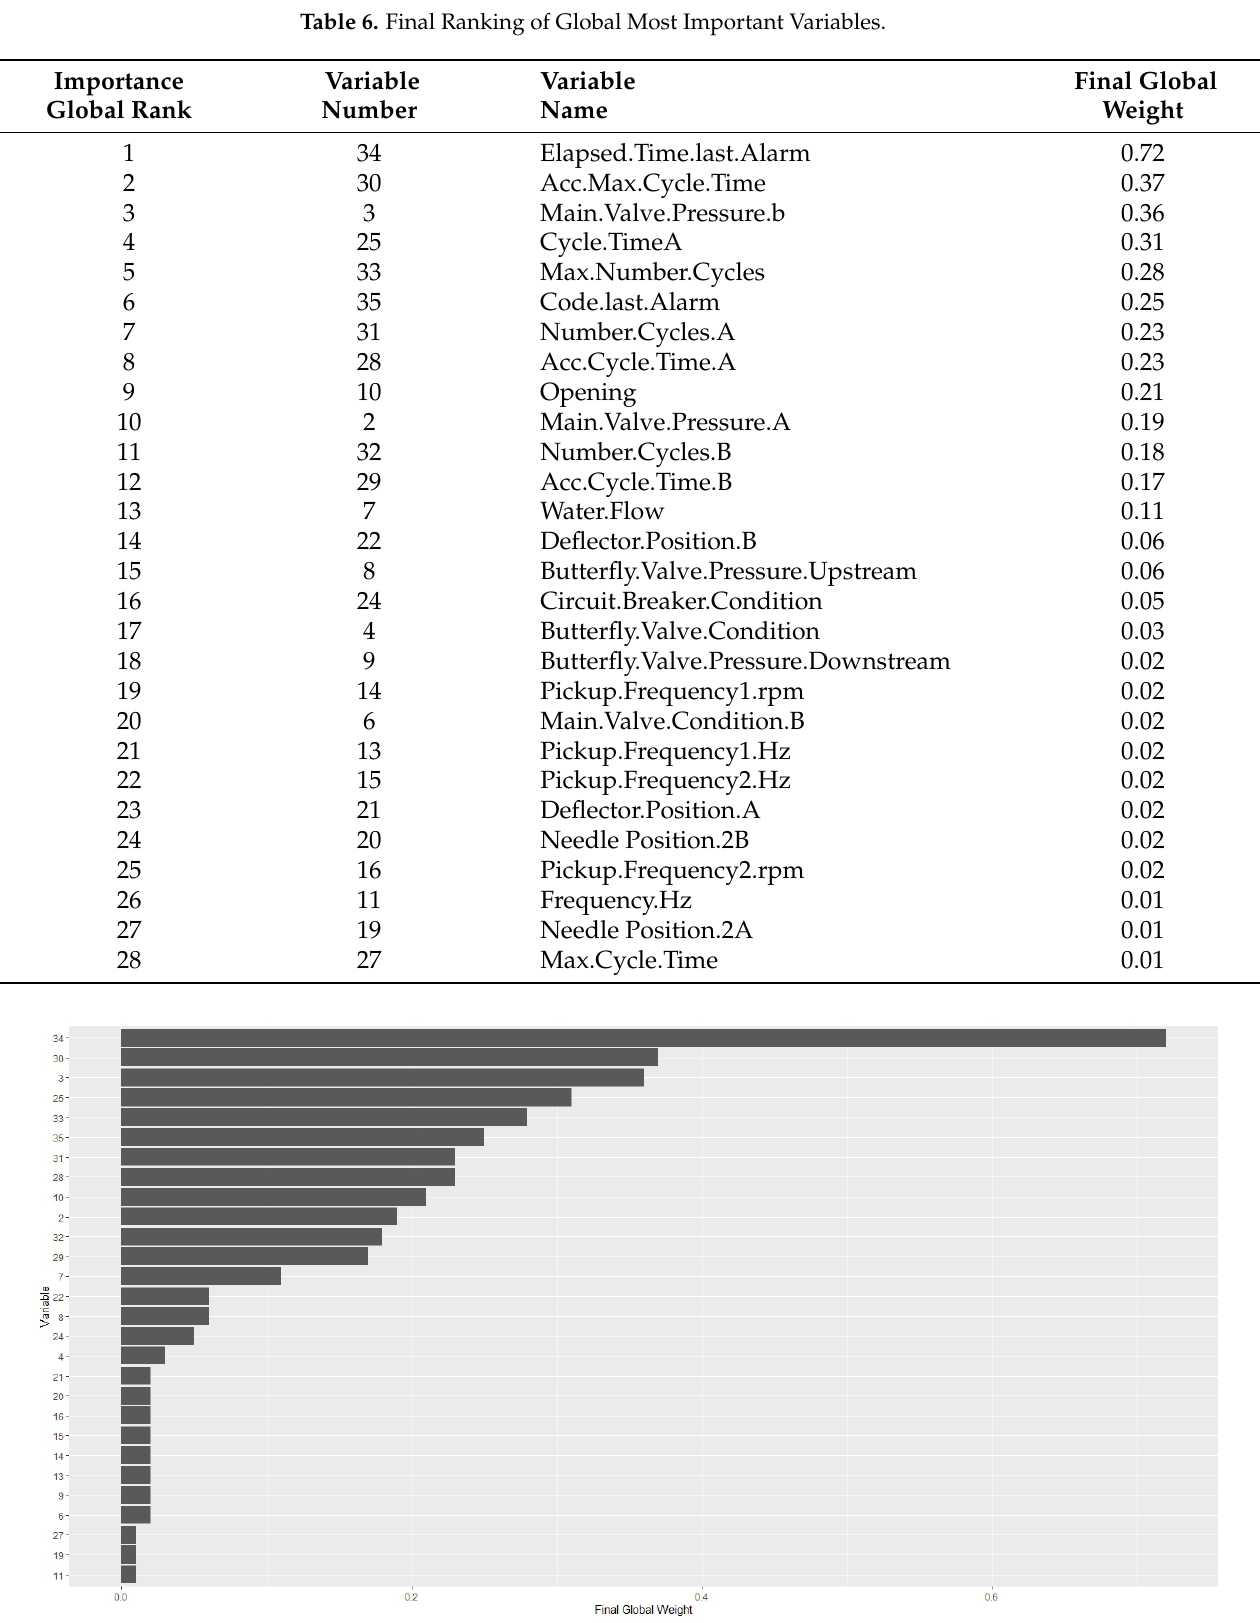
Figure 9. Final Ranking of Global Most Important